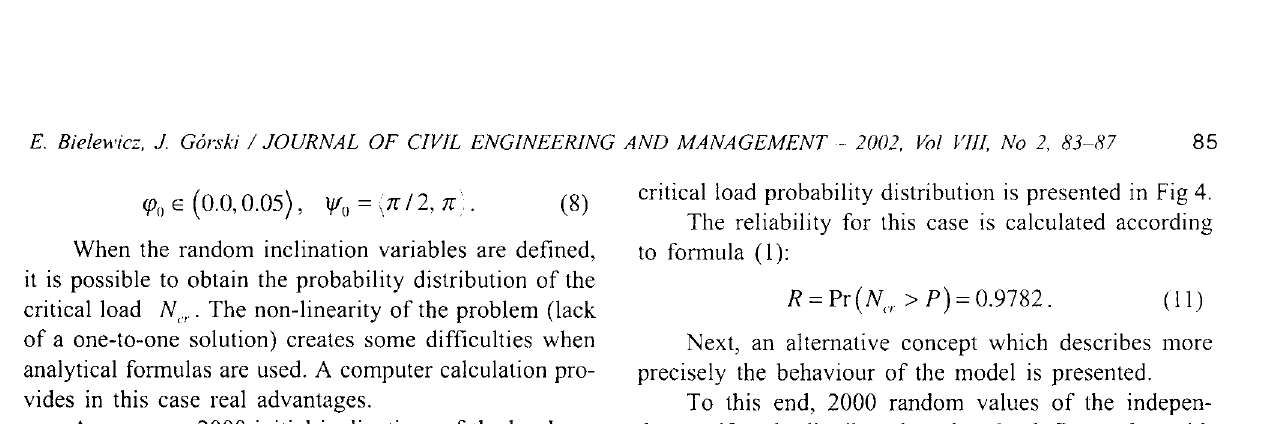
Fig 3. Case I a: histogram of the critical load Ncr and the probability distribution of load P